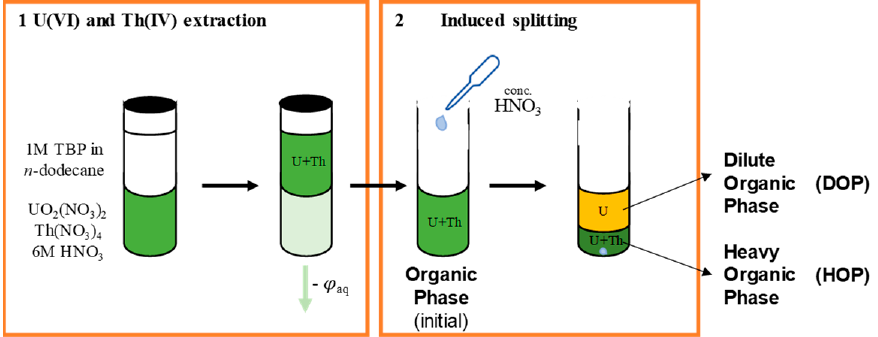
Figure 2. Schematic diagram of organic phase splitting induced by acid addition. Table 1. Organic phases employed in acid induced organic phase splitting. All phases are in 1 M TBP in n -dodecane, pre-equilibrated with 6 M aqueous HNO 3 . Organic Phase